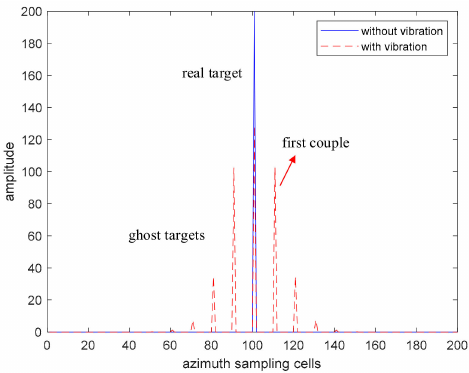
Figure 2. The azimuth compression results with or without platform vibration. The blue line represents the azimuth compression result without platform vibration. The red dashed line represents the azimuth compression result with platform